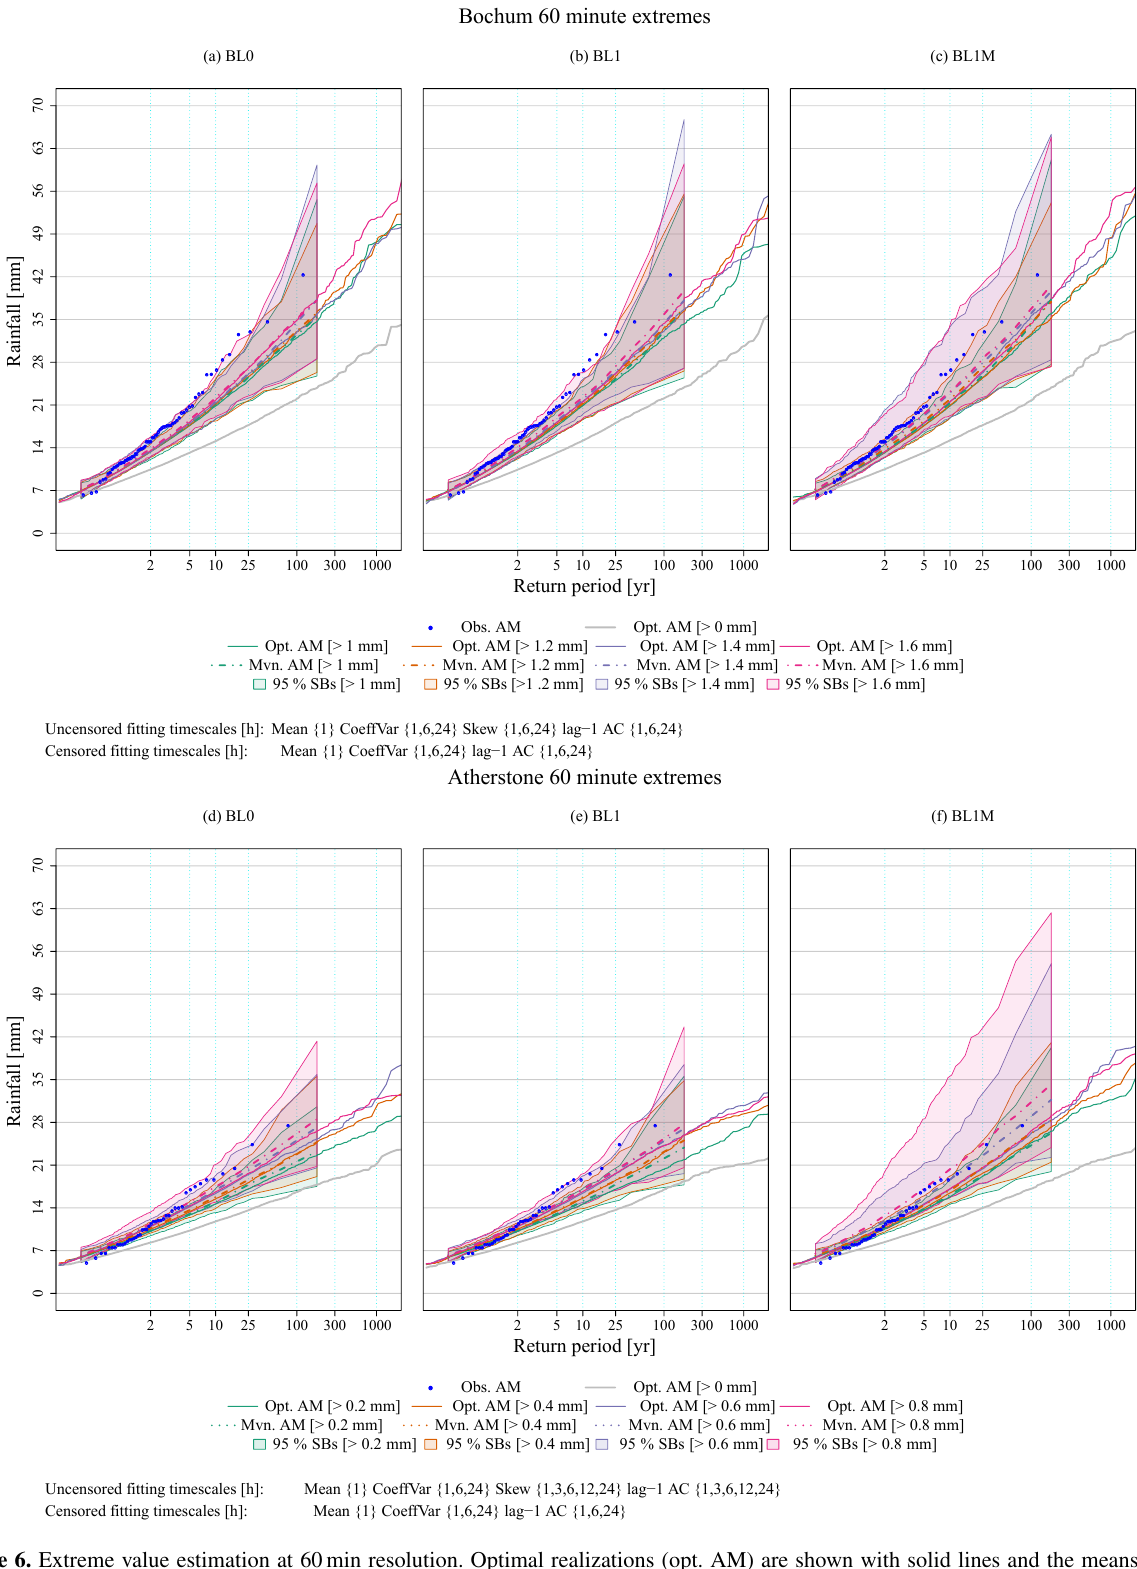
Hydrol. Earth Syst. Sci., 22, 727–756,